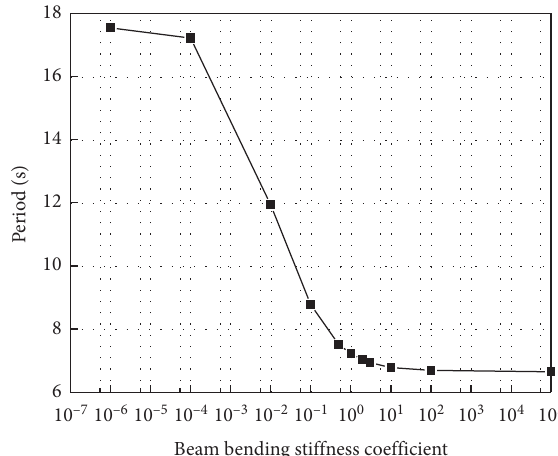
Figure 10: Influence of the column section shear stiffness coeffi- cient on the period.